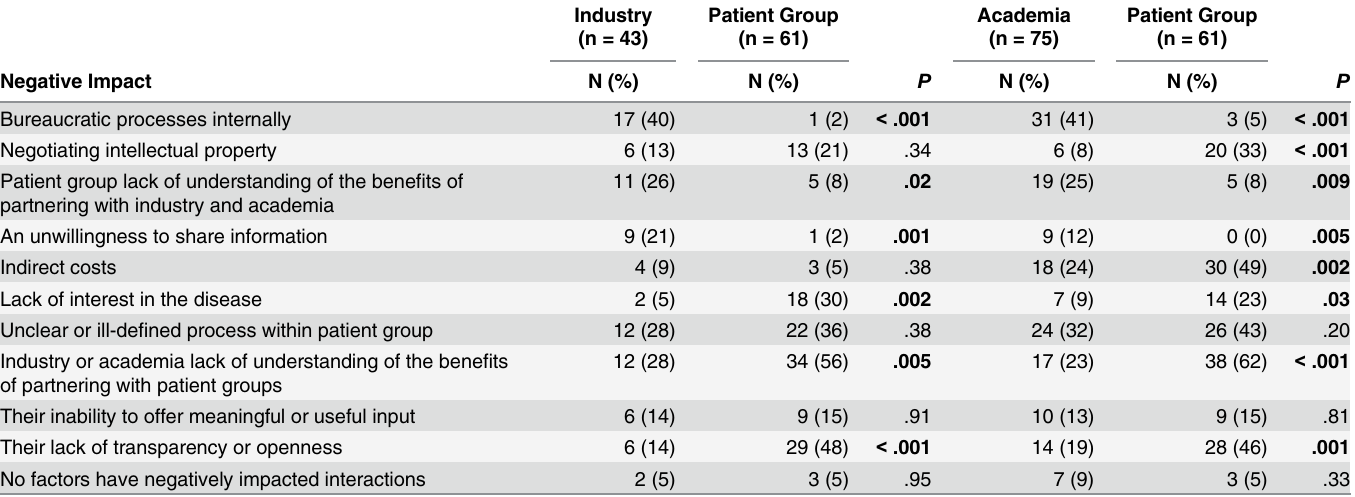
Table 4. Negative Impacts to Relations Between Patient Groups and Industry/Academia * .